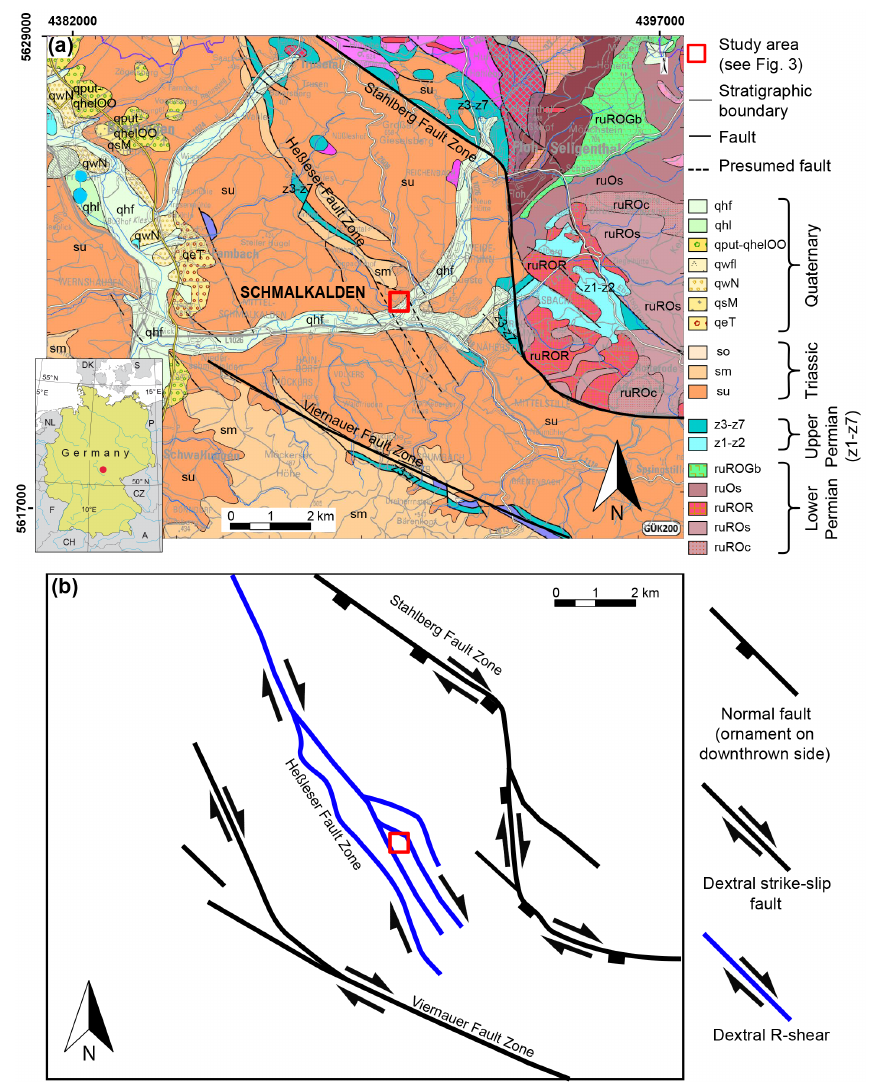
Figure 1. Geological map (a) of Schmalkalden and the surrounding areas (after Bücking, 1906), showing the Heßleser Fault zone (HFZ) crossing the position of the sinkhole (red square). In the lower-left corner a map of Germany shows the position of Schmalkalden (red dot). Our interpretation of the fault movement (b) is that they were reactivated in the Mesozoic, which led to the formation of a dextral strike-slip fault zone, which includes the Stahlberg Fault zone (SFZ) and the Viernauer Fault zone (VFZ). The HFZ connects the two major faults at an acute angle of 30 ◦ . We interpret this as a Riedel R-shear that is also dextral in movement (see text). For an explanation of the stratigraphic abbreviations, see LBEG